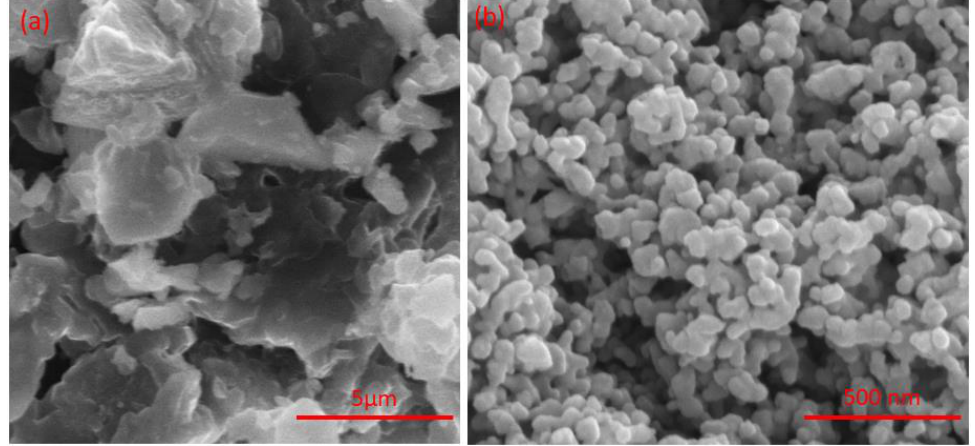
Figure 5. FESEM images of ( a ) Mg-Ca-Al-LDH and ( b ) Mg-Ca-Al-LDO composite materials.